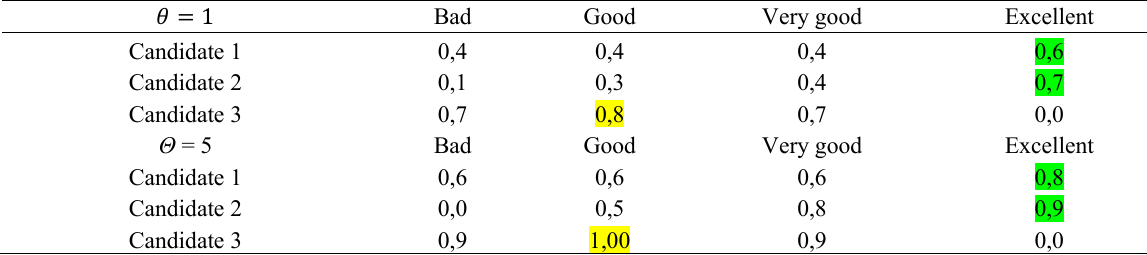
Global classification of alternatives 𝜃 = 1 Bad Good Very good Excellent